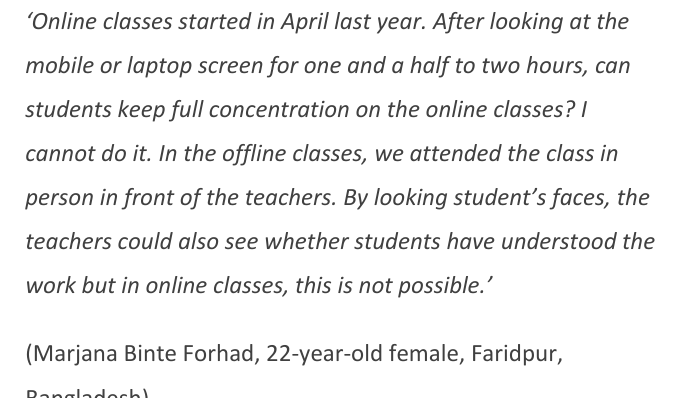
Figure 10. Alt-text: A desk with notes, pens and pencils and an online class being streamed on a phone.